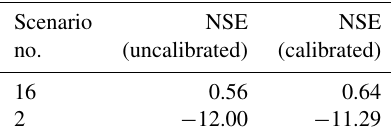
Table 4. Values of NSE calculated for uncalibrated and calibrated best- and poorest-performing scenarios (16 and 2, respectively) for discharge